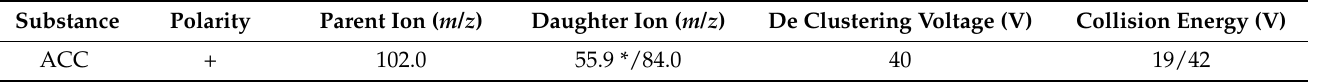
Table 1. Selected reaction monitoring conditions for protonated or deprotonated plant hormones ([M+H] + or [M − H] − ).